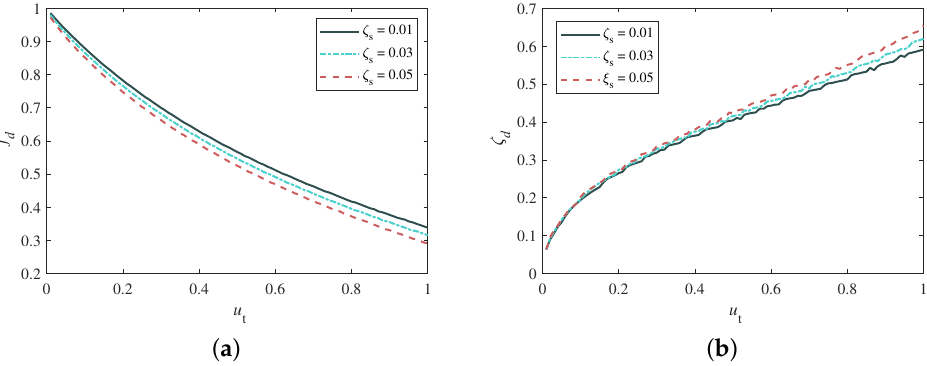
Figure 3. The optimal design parameters of TMD with the various mass ratios u t : ( a ) Tuning frequency ( f d ) and ( b ) Damping ratio ( ζ d